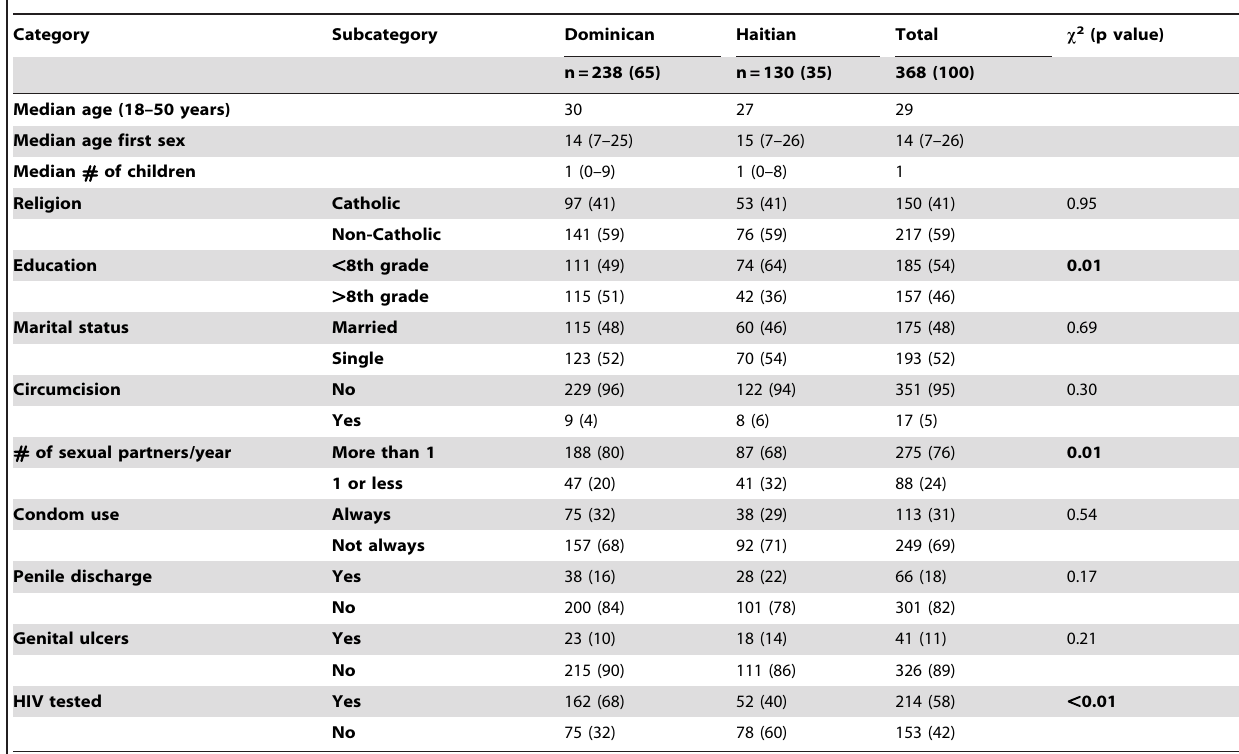
Table 1. Subject characteristics by national